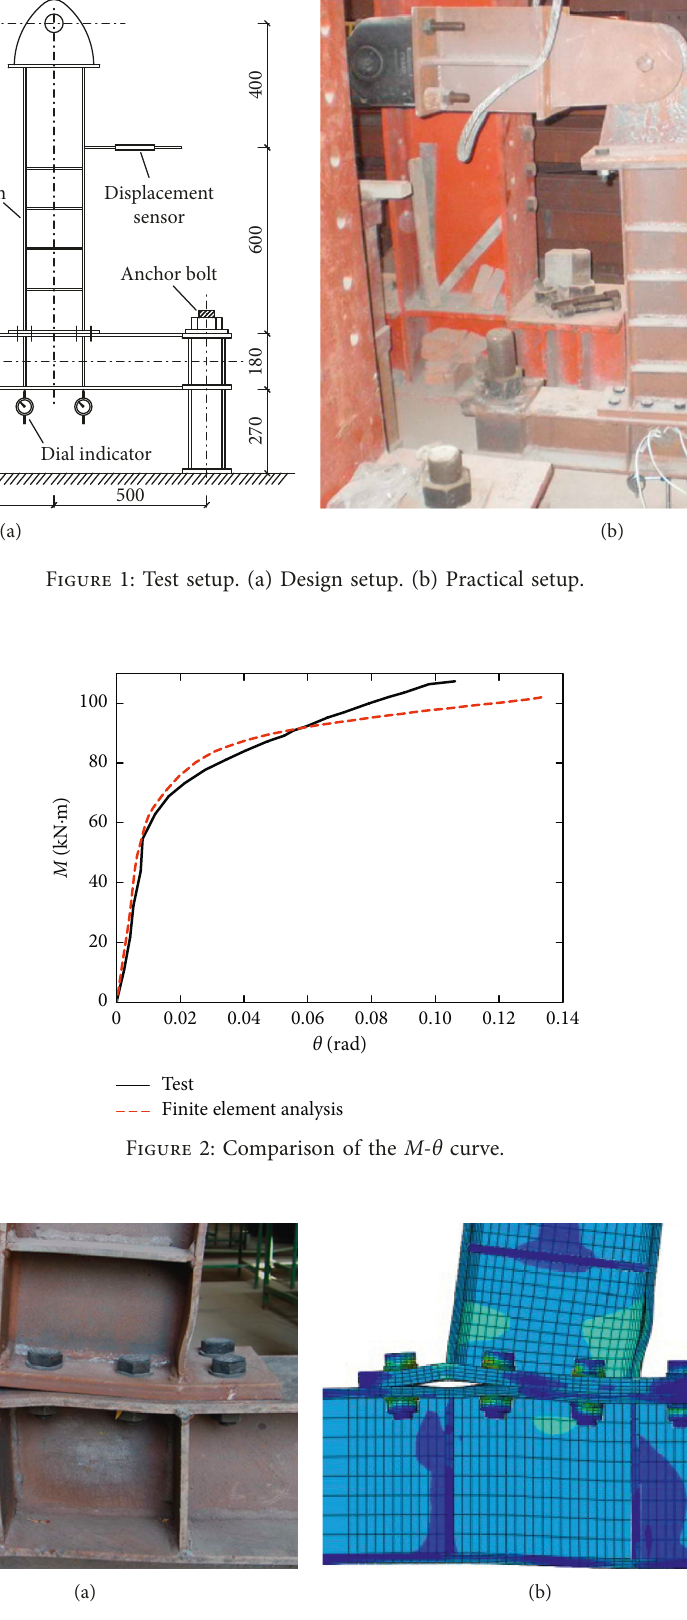
Figure 3: Comparison of the failure mode. (a) Experiment. (b)